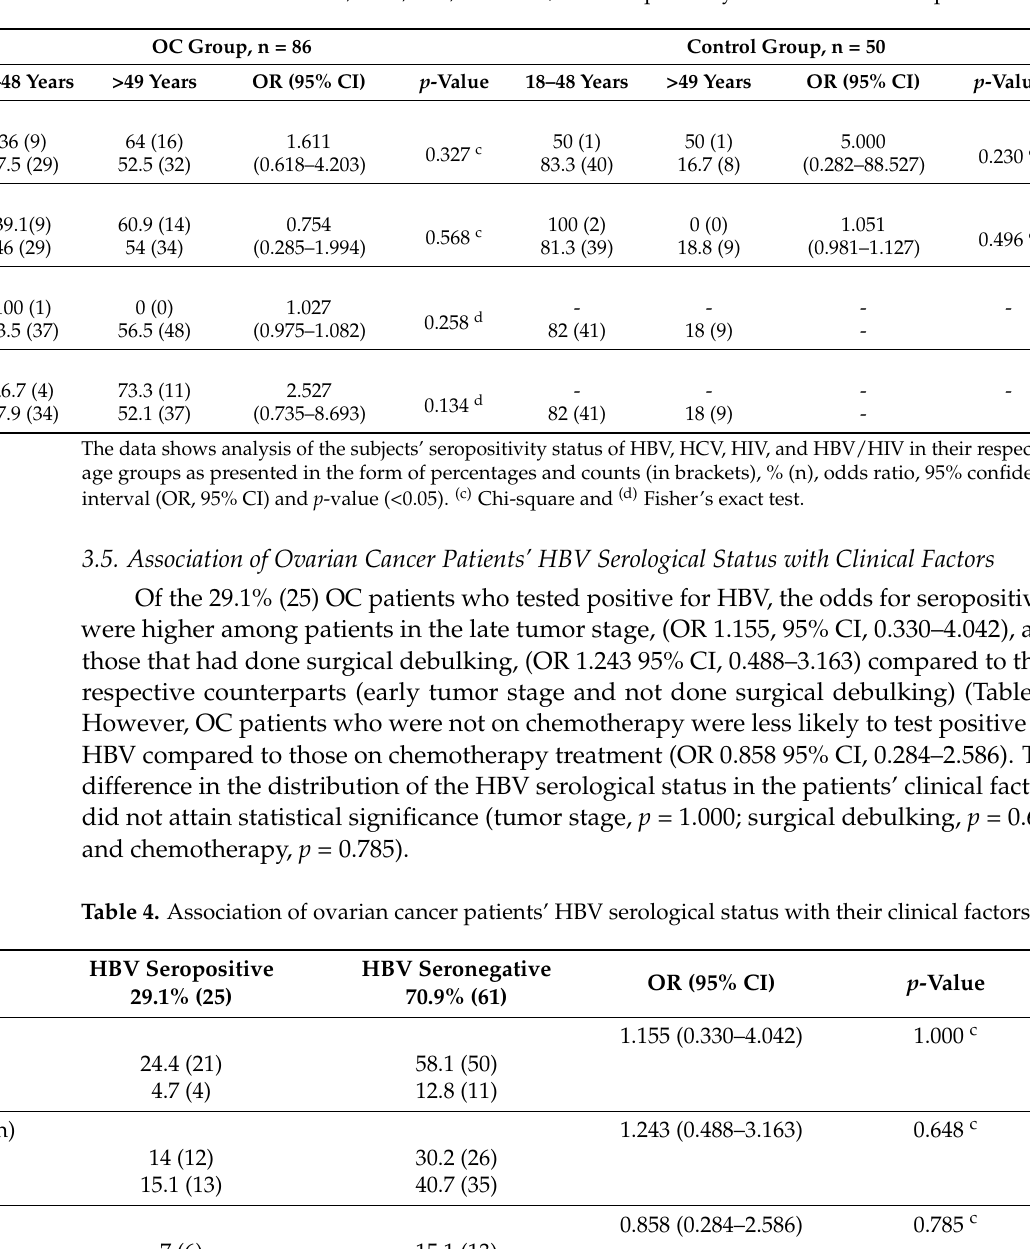
Table 3. Association of HBV, HCV, HIV, and HBV/HIV seropositivity status with the menopausal status.